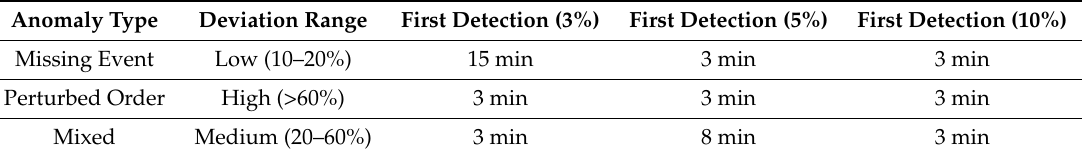
Table 2. Summary of detection